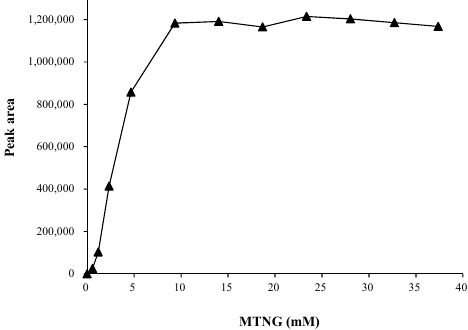
Figure 2. Effects of the concentration of added MTNG on the derivatization yield. The peak areas of 8-nitroG-MTNG obtained from the derivatization of a hydrolysate of calf thymus DNA containing 1 μ M 8-nitroG. Points denote the mean values of duplicates.